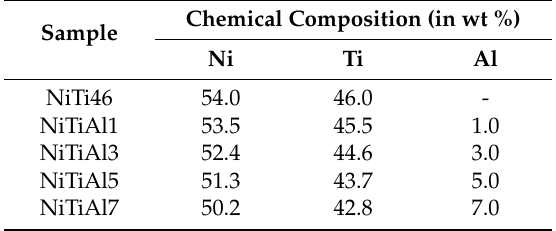
Table 2. Chemical compositions of the prepared powder